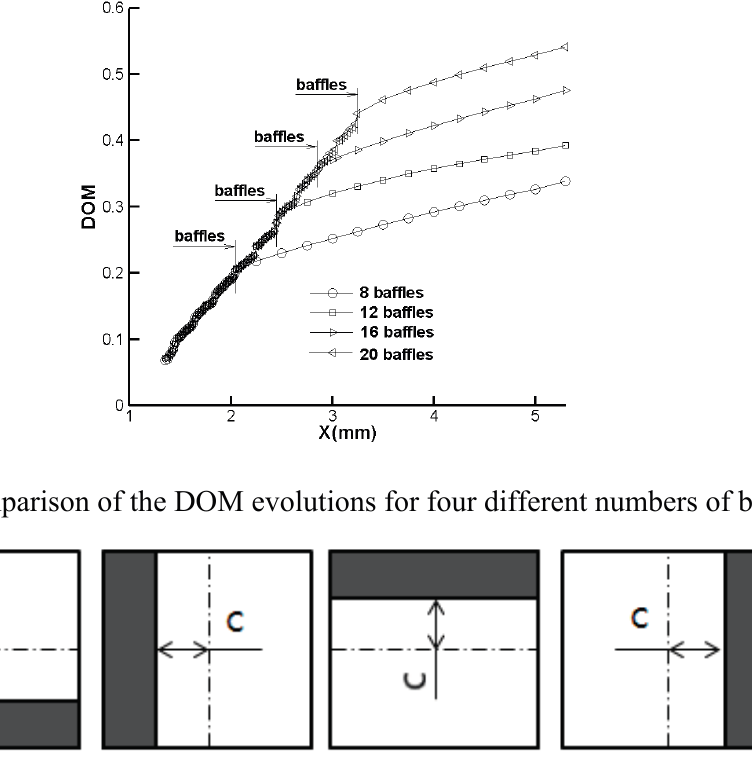
Figure 10. Definition of clearance gap c